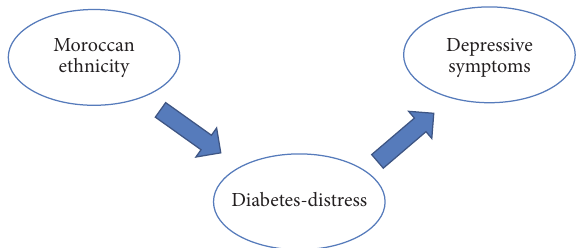
Figure 1: The mediating effect of diabetes-distress between Moroc- can ethnicity and depressive symptoms.